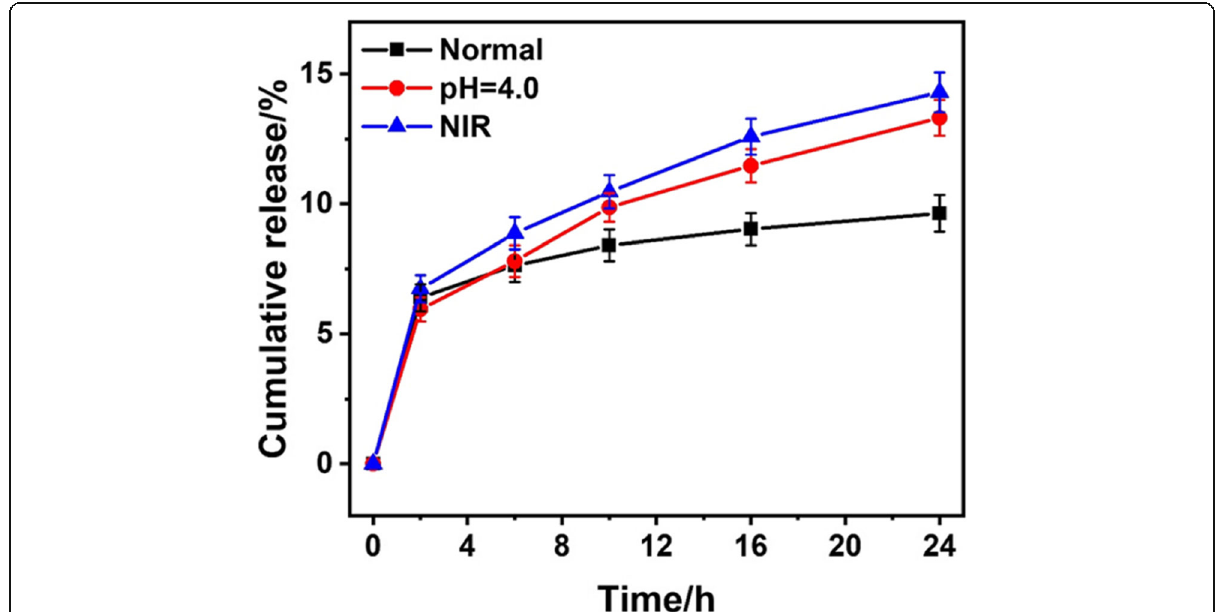
Fig. 9 In vitro drug release profiles of DOX@NrGO under different